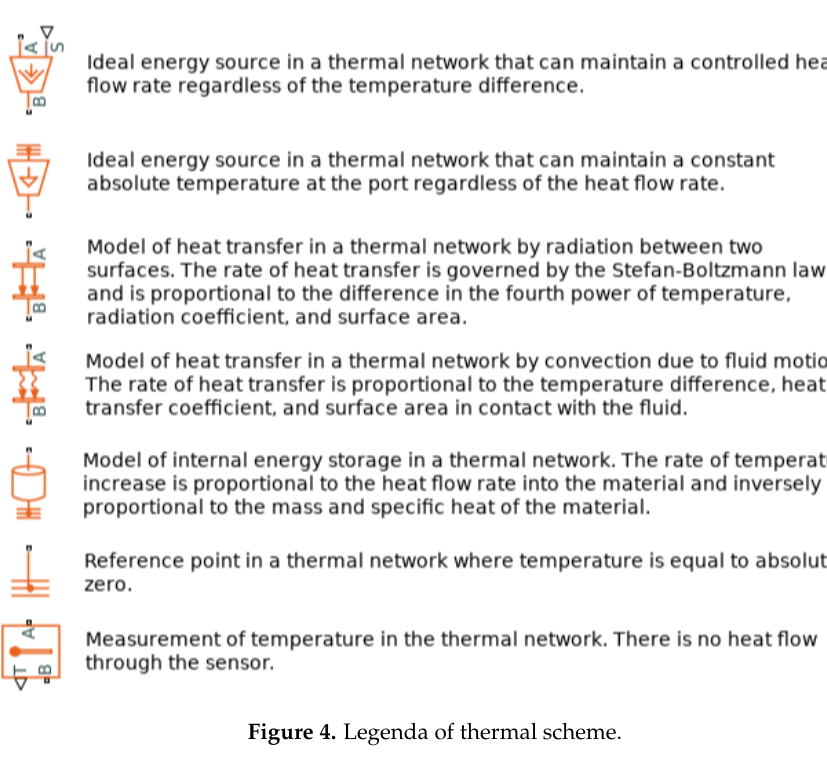
Figure 4. Legenda of thermal